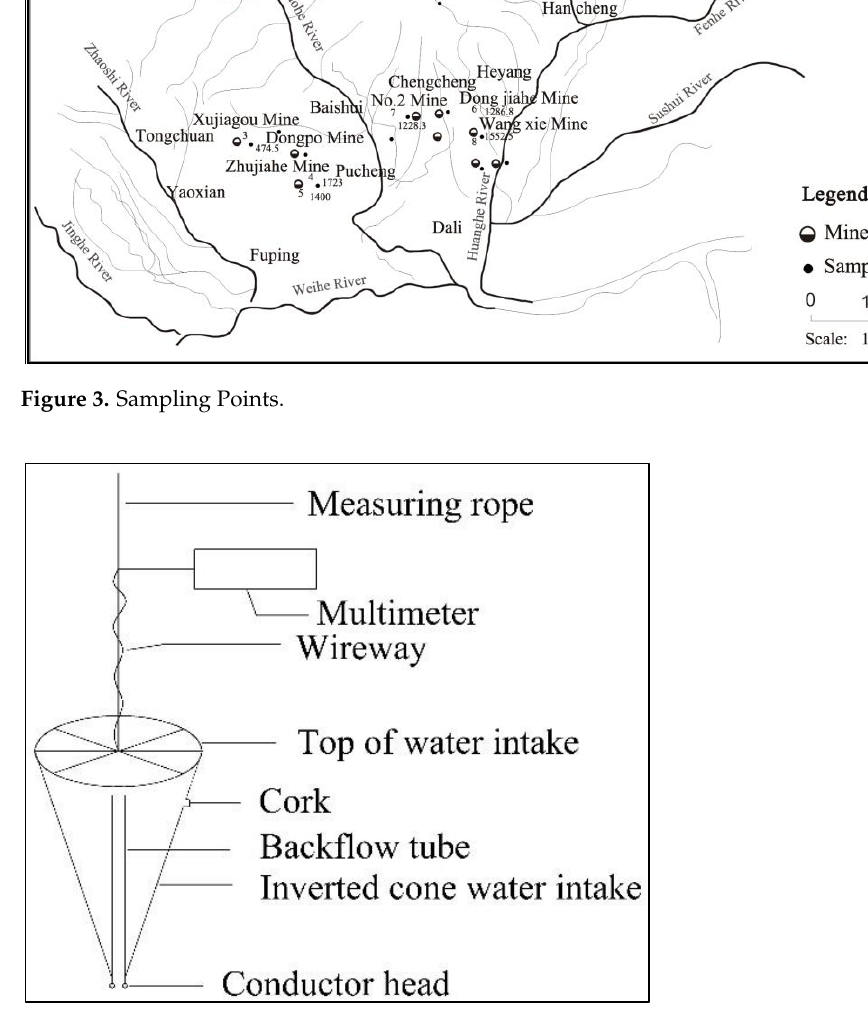
Figure 4. Schematic diagram of a deep-hole water dispenser.